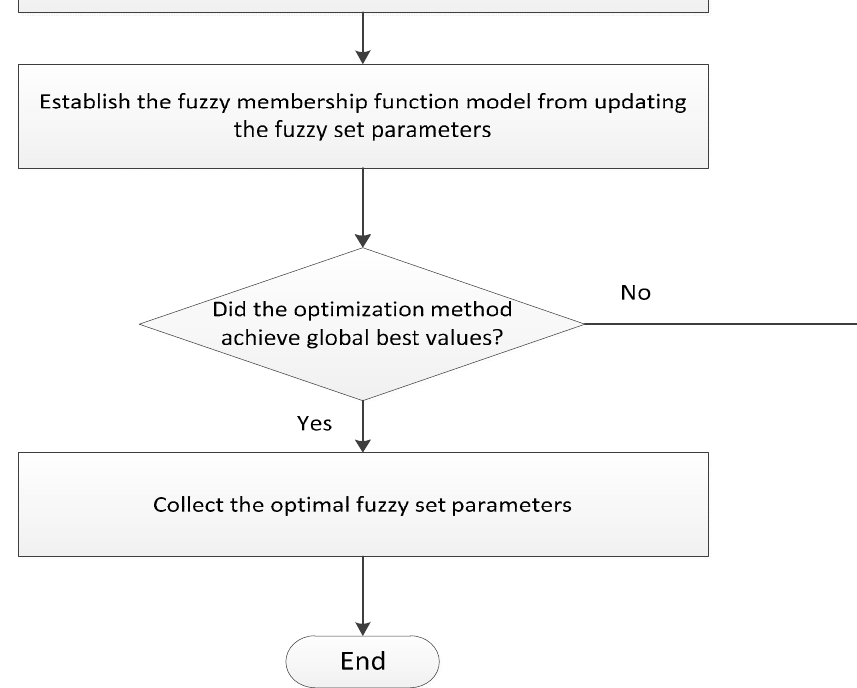
Figure 9. Particle Swarm Optimization to adjust membership functions.